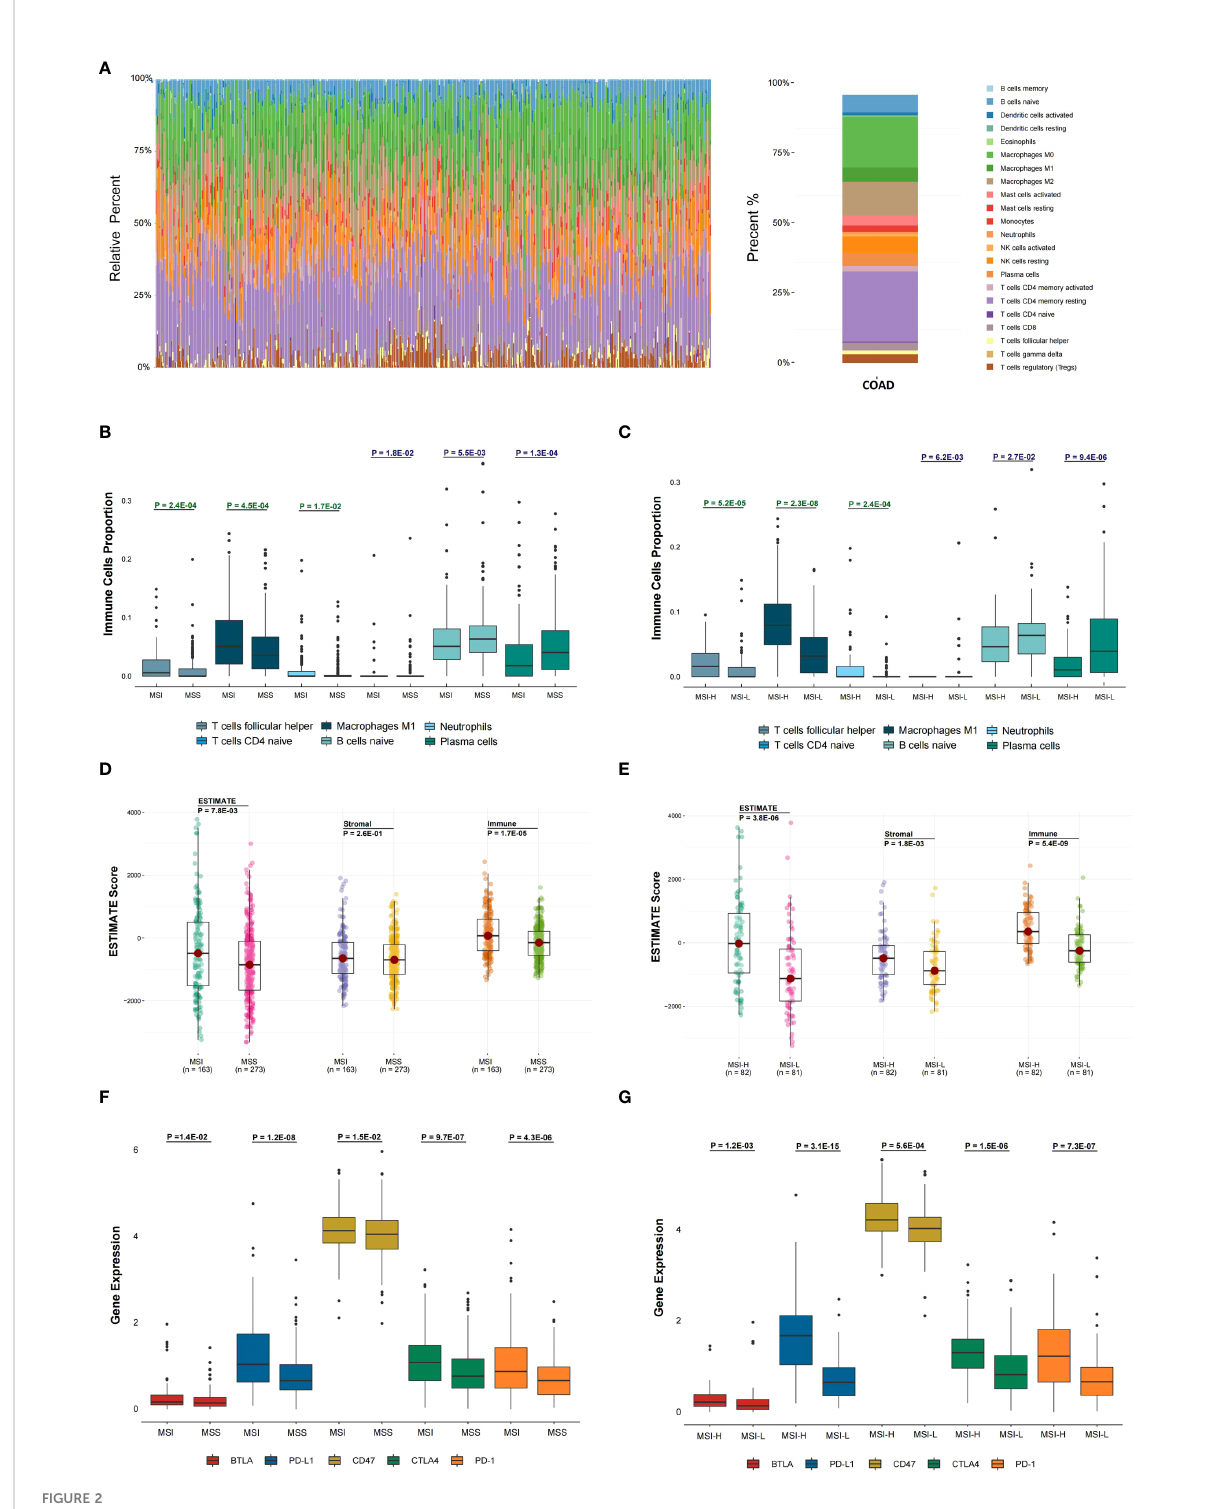
FIGURE 2 Evaluation of the association between microsatellite stability status and tumor immune in fi ltration. (A) In the TCGA COAD cohort, 22 immune cell proportion and distribution using CIBERSORT are shown. (B) The six immune cells in fi ltration difference between MSI and MSS groups. (C) The difference of six immune cells in fi ltration between MSI-L and MSI-H groups and (D) The difference in ESTIMATE score between MSI and MSS groups was analyzed. (E) The difference in ESTIMATE score between MSI-L and MSI-H groups was analyzed. (F, G) The differential expression status of fi ve immune checkpoints between different MSI groups was analyzed. The one-sided Wilcoxon rank-sum test was utilized to compute